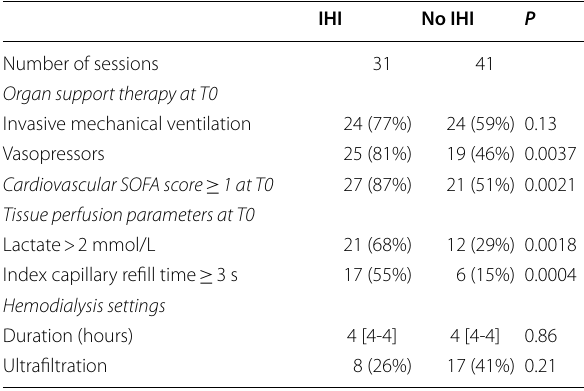
Table 3 Characteristics of first hemodialysis sessions at